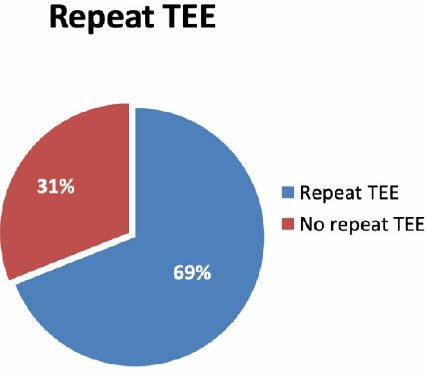
Figure 2. Repeat TTE: TEE, transesophageal echocardiogram. List of abbreviations: TEE, transesophageal echocardiogram.